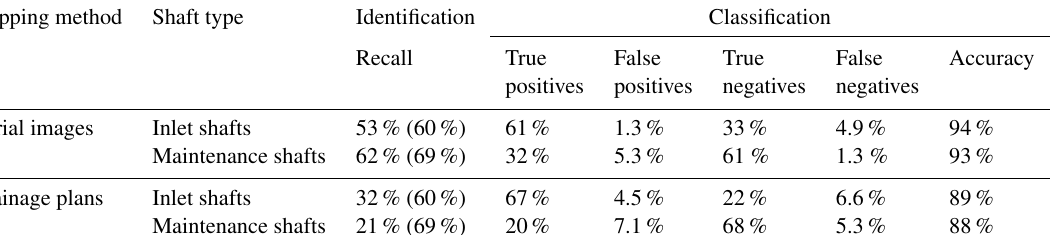
Table 5. Recall and classification accuracies of the mapping methods of aerial images and drainage plans. The recall corresponds to the probability that a potential shortcut is found by the mapping method. Percentages indicate the recall of each individual mapping method. In parentheses, the recall of the combination of both methods is given. The accuracy corresponds to the sum of true positive fraction and true negative fraction.